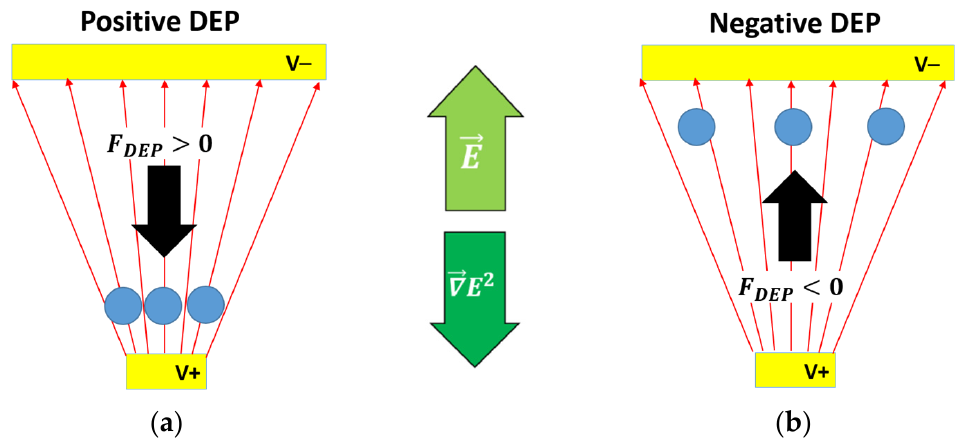
Figure 1. Particles’ interaction in a non-uniform applied field: ( a ) the DEP force is positive, i.e., collinear to the electric field gradient ∇ E², and the particles are attracted to areas of high field intensity (positive DEP); ( b ) the DEP force is negative, i.e., opposite to the electric field gradient ∇ E², and the particles are repelled toward areas of low field intensity (negative DEP).